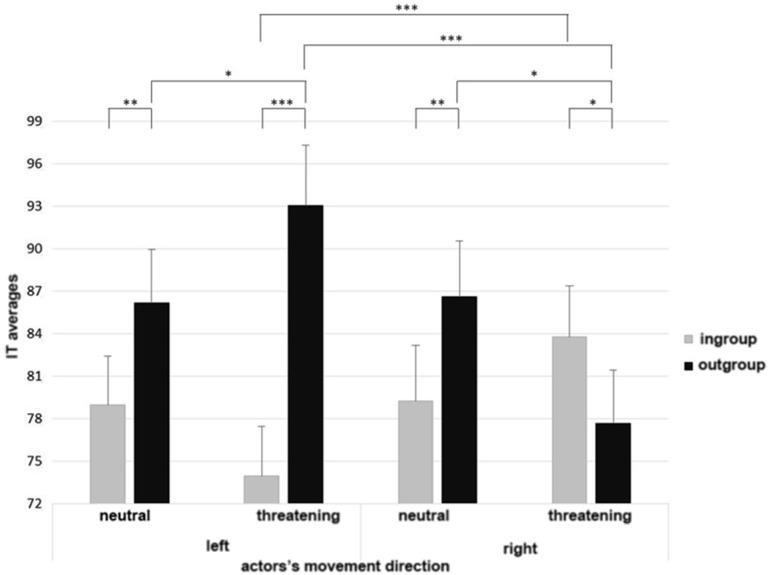
Three-way interactions between membership, actor’s movement direction, and object valence [Initial Times (IT)]. Asterisks highlight significantly different means comparisons (∗p < 0.05, ∗∗p < 0.01, ∗∗∗p < 0.001). Error bars represent standard errors.